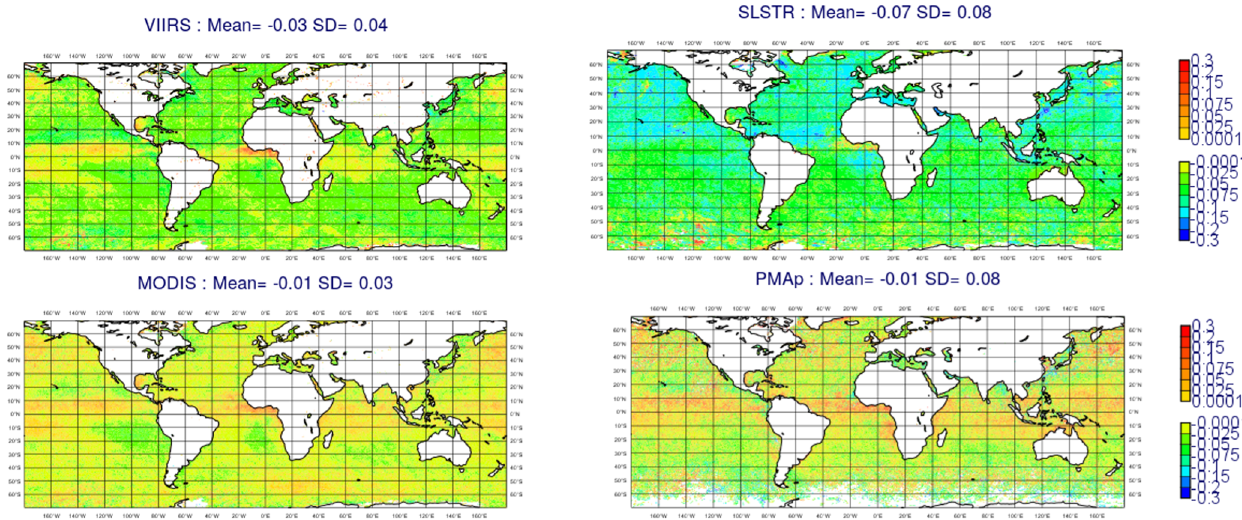
Figure D3. Global maps of the mean of the first-guess departure from Terra and Aqua/MODIS, NOAA20 and SNPP/VIIRS, S3A and S3B/SLSTR, and MetOp-A/B–PMAp for the MAM period over